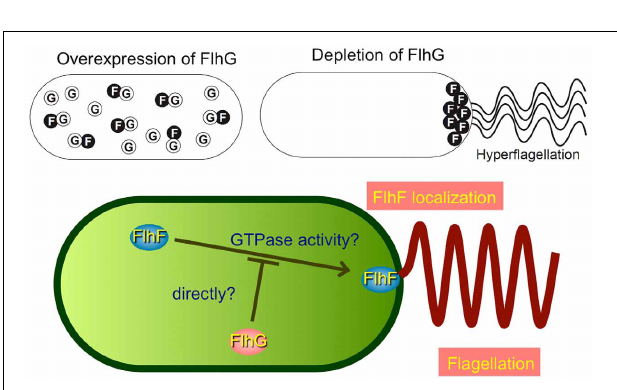
FIGURE 4 | Model for regulation of the number of polar flagella in Vibrio . The function of FlhF is probably inhibited by an interaction with FlhG, a negative regulator of FlhF, and thereby the number of polar flagellum is limited to one. The schemes are drawn based on a previous report (Kusumoto et al., 2008).